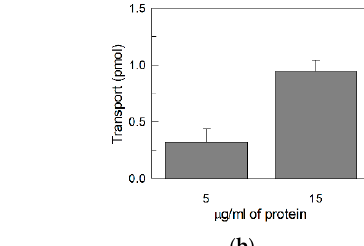
Figure 3. Dependence of the transport activity of hRFVT2 on the pH. Purified RFVT2 was reconstituted in proteoliposomes. [ 3 H]Riboflavin uptake into proteoliposomes was performed at the indicated pH and stopped after 20 min as described in the Material and Methods section. The values are means ± standard deviation (SD) from three experiments.